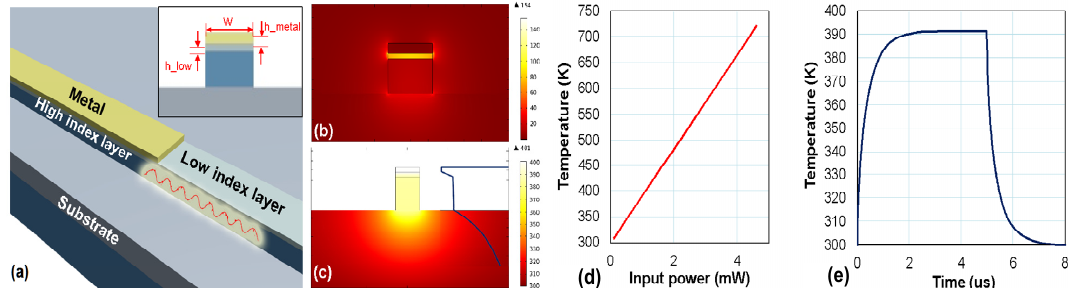
Figure 12. ( a ) Configuration of the photo-thermal detector based on a silicon hybrid plasmonic waveguide; ( b ) The optical field distribution of the silicon hybrid plasmonic waveguide with a core width w = 300 nm @ λ = 3.39 µ m; ( c ) The temperature profile of the silicon hybrid plasmonic waveguide when 1 mW power is applied in the metal strip; ( d ) The maximal temperature in the metal strip as the input power varies; ( e ) The temporal response of the temperature of the metal strip with an applied power of 1 mW